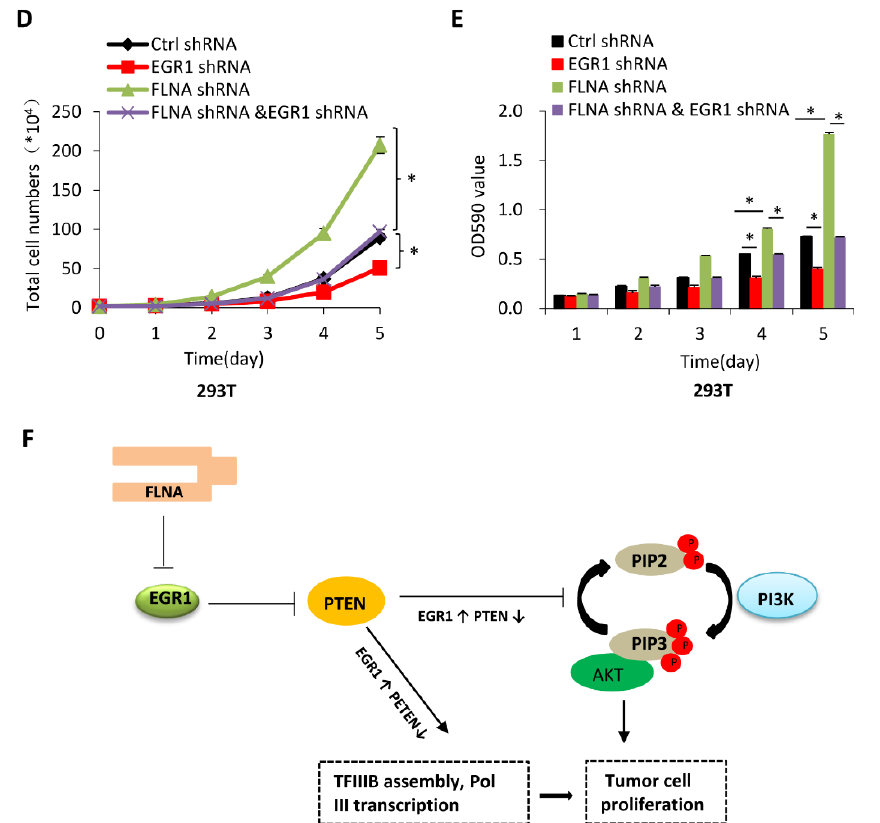
Figure 7. EGR1 is required for the regulation of Pol-III-directed transcription mediated by FLNA: ( A , B ) FLNA and EGR1 expression was determined by RT-qPCR ( A ) and Western blot ( B ) using 293T cell lines expressing both FLNA shRNA and EGR1 shRNA or FLNA shRNA only and the control cell line. F/G and E/G, respectively, represent the ratio of FLNA (F), and EGR1 (E) intensities to the GAPDH (G) intensity ( n = 3); ( C ) EGR1 downregulation inhibited the activation of Pol-III-directed transcription caused by FLNA depletion in 293T cells. Expression of Pol III products was monitored by RT-qPCR using the cell line established in ( A ); ( D , E ) EGR1 downregulation inhibited the enhancement of cell proliferation caused by FLNA silencing. Cell proliferation activity was measured by cell counting ( D ) and MTT assays ( E ); ( F ) a pathway by which FLNA and EGR1 regulate Pol-III-directed transcription was proposed based on the data obtained in this study. Each column in the point–line and bar graphs represents the mean ± SD of three biological replicates ( n = 3). *, p < 0.05; **, p < 0.01. p values for ( A ) were obtained by Student’s t -test by comparing two groups as indicated; p values for ( D , E ) were obtained by two-way ANOVA; p values for ( C ) were obtained by one-way ANOVA, followed by Bonferroni test, with a comparison of two groups among multiple